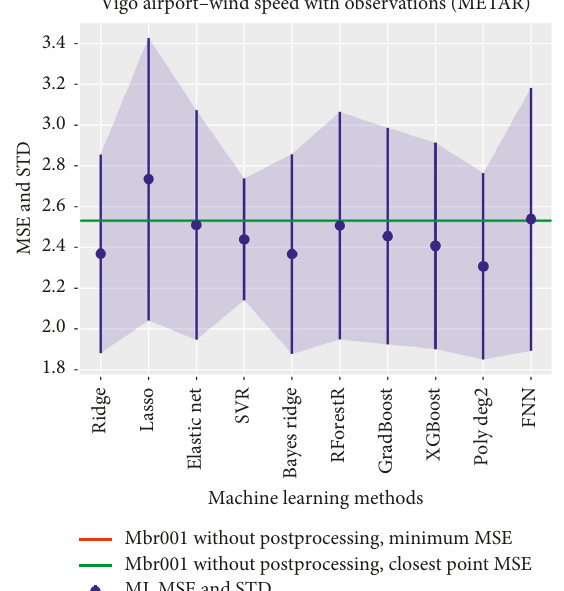
Figure 15: 10meters total wind calibration plot for Vigo airport. Horizontal axis as in Figure 12.